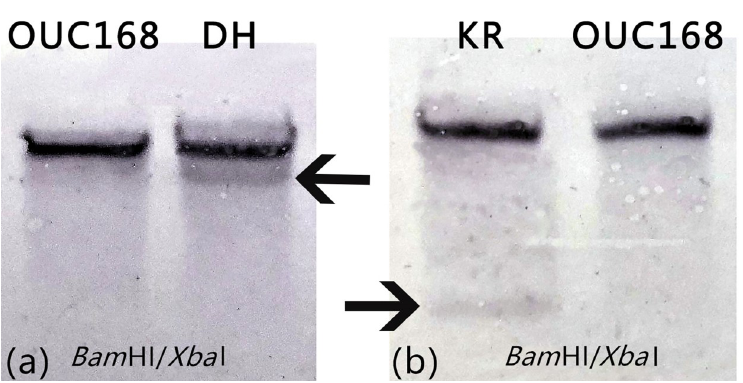
Fig 5. Southern blotting analysis of kr or dh in the genomic DNA of transformants. (a) The Southern blotting hybridization results for the dh gene (b) The Southern blotting hybridization results for the kr gene.